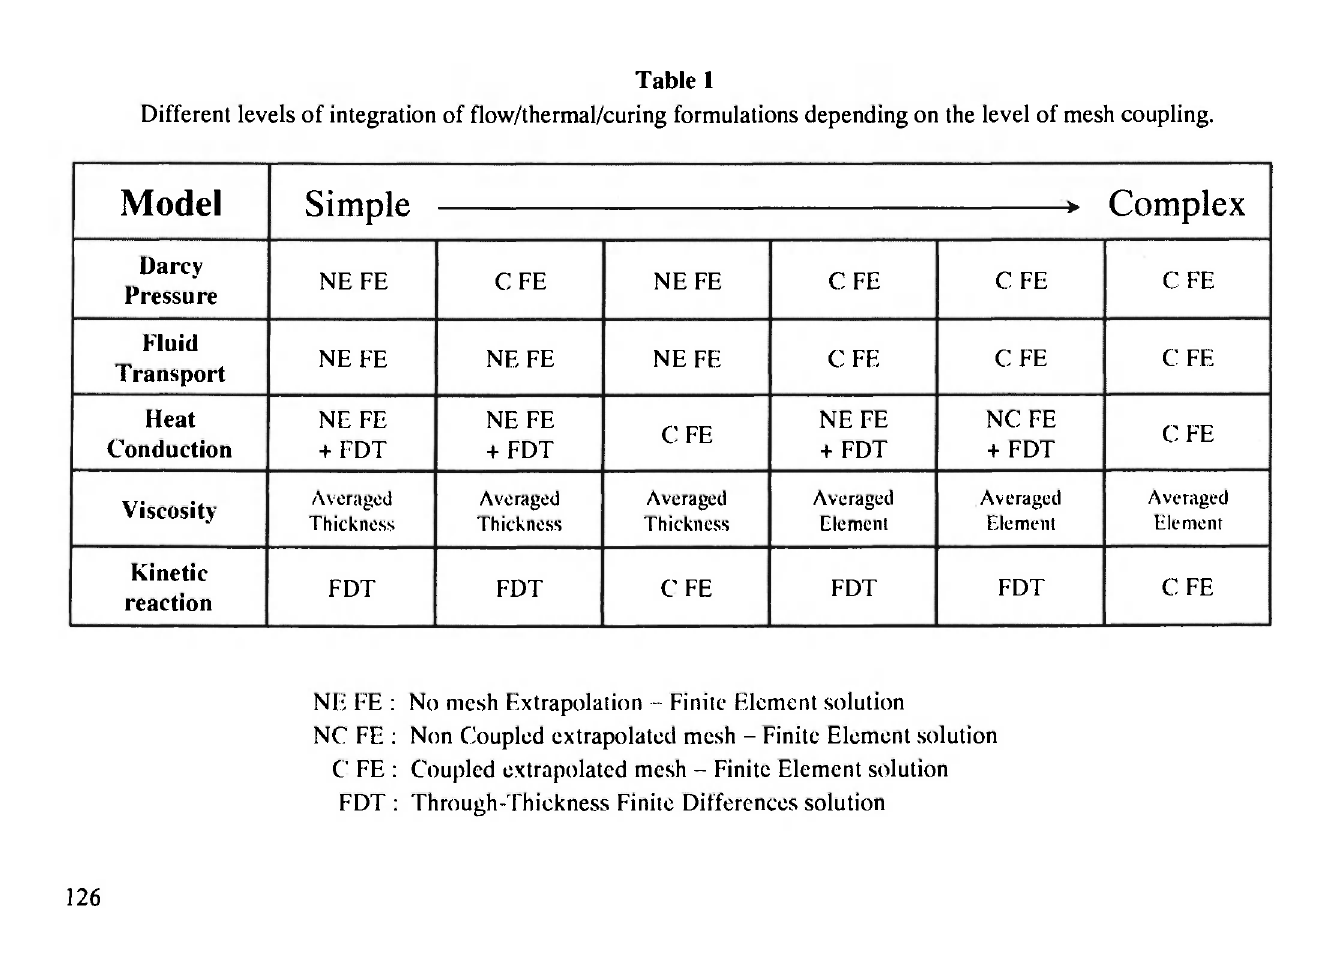
Fig. 7: Schematic representation showing increasingly complex integration of flow, conduction and transport solutions. Different levels degrees of coupling are obtained by combining FE meshes and FD grids.